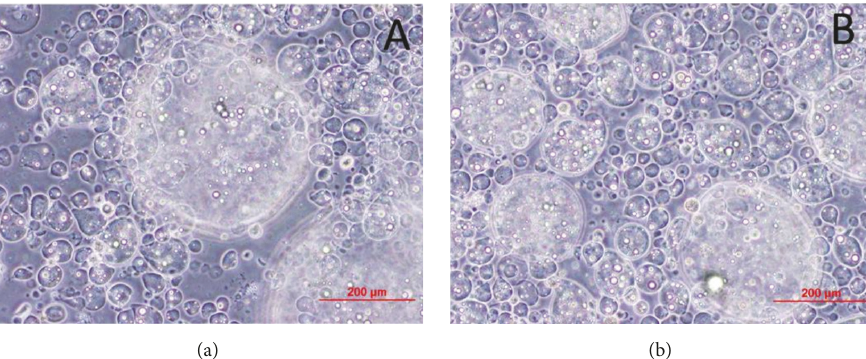
Figure 4: Encapsulated cells under microscope (a) before and (b) after no. 18 needle push pass test. No microcapsule breakage was observed after the test.